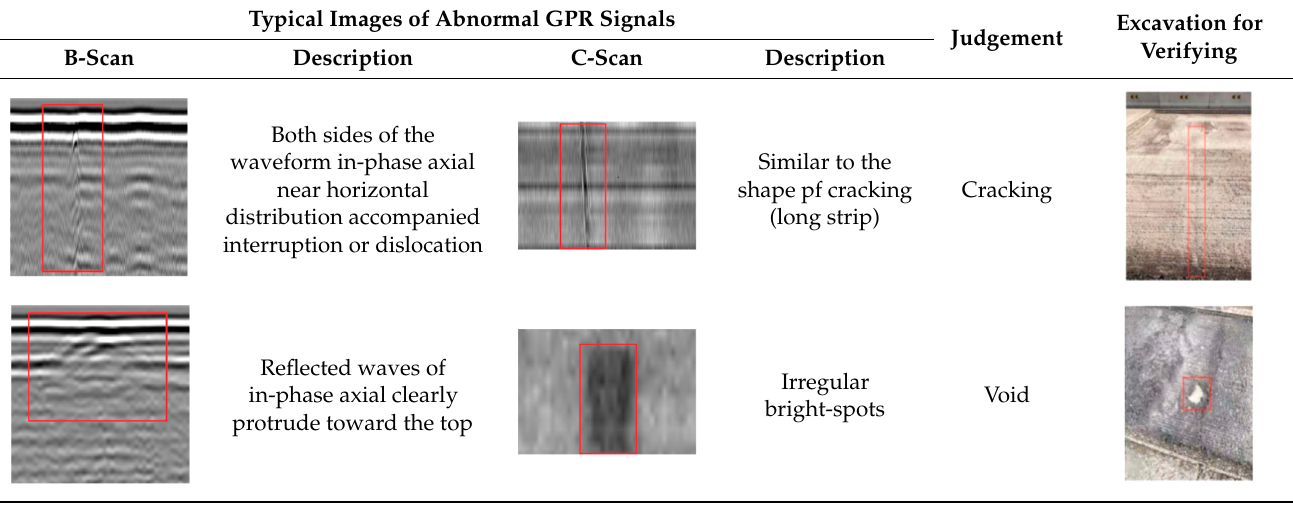
Table 4. The classification criteria of